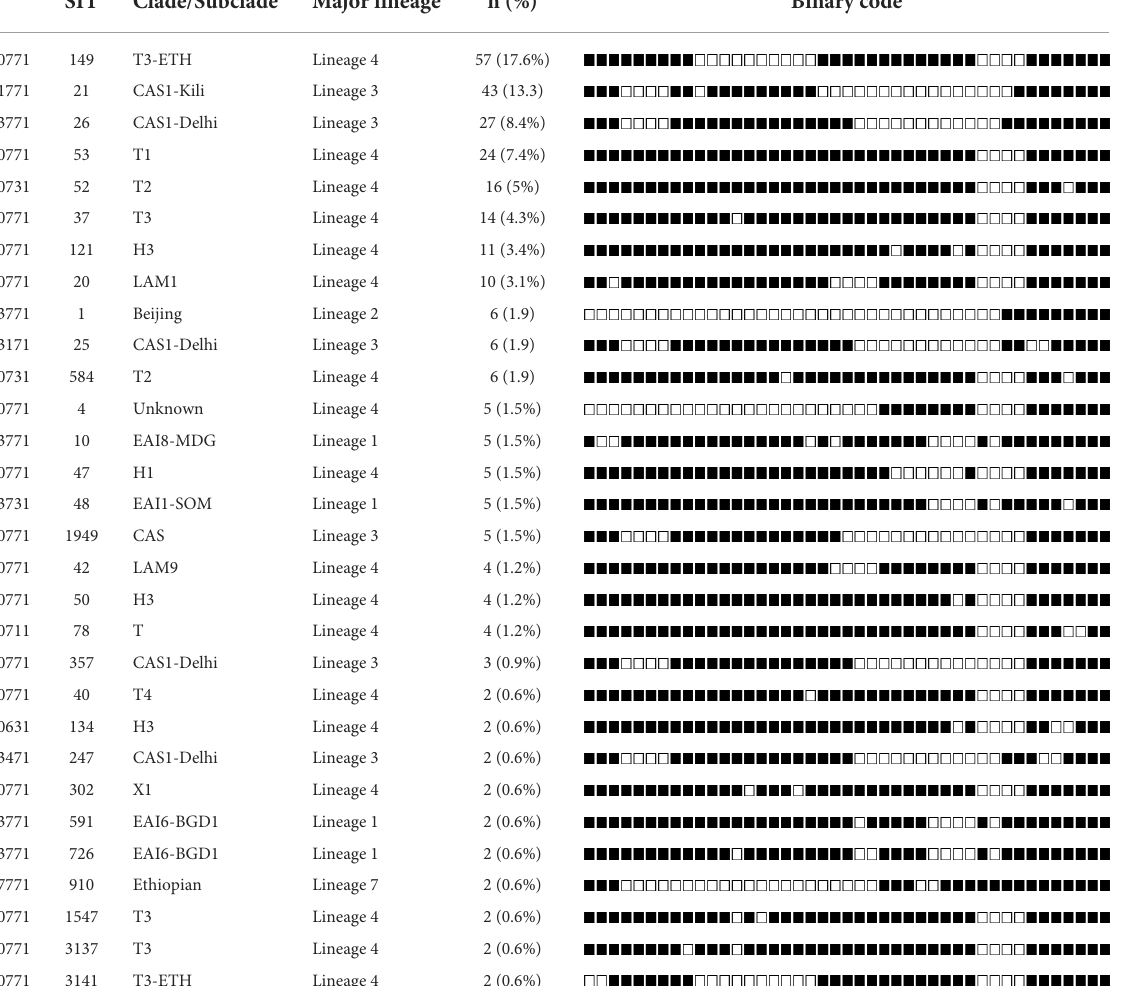
TABLE 3 Spoligotype patterns of clustered M. tuberculosis complex isolates ( n = 284) TB patients in Somali region, Ethiopia.